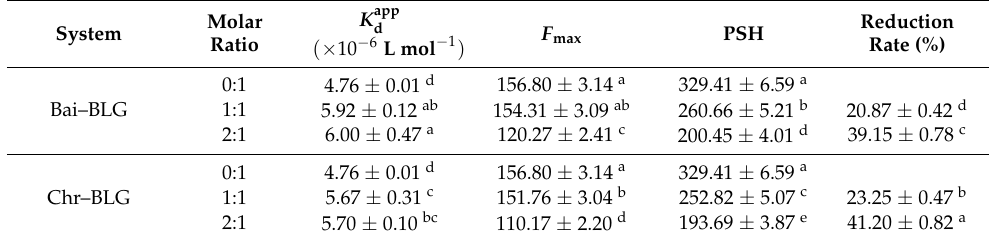
Figure 4. Binding of ANS to BLG in the absence and presence of Bai ( A ) and Chr ( B ). c (BLG) = 20.0 µ M. The molar ratios of BLG to Bai or Chr were 1:0, 1:1 and 1:2. Scatcherd plots for the titration with increasing concentrations of ANS relative to BLG in the absence and presence of Bai ( C ) and Chr ( D ). Table 3. Effect of Bai/Chr on surface hydrophobicity of BLG at different molar ratios of BLG to